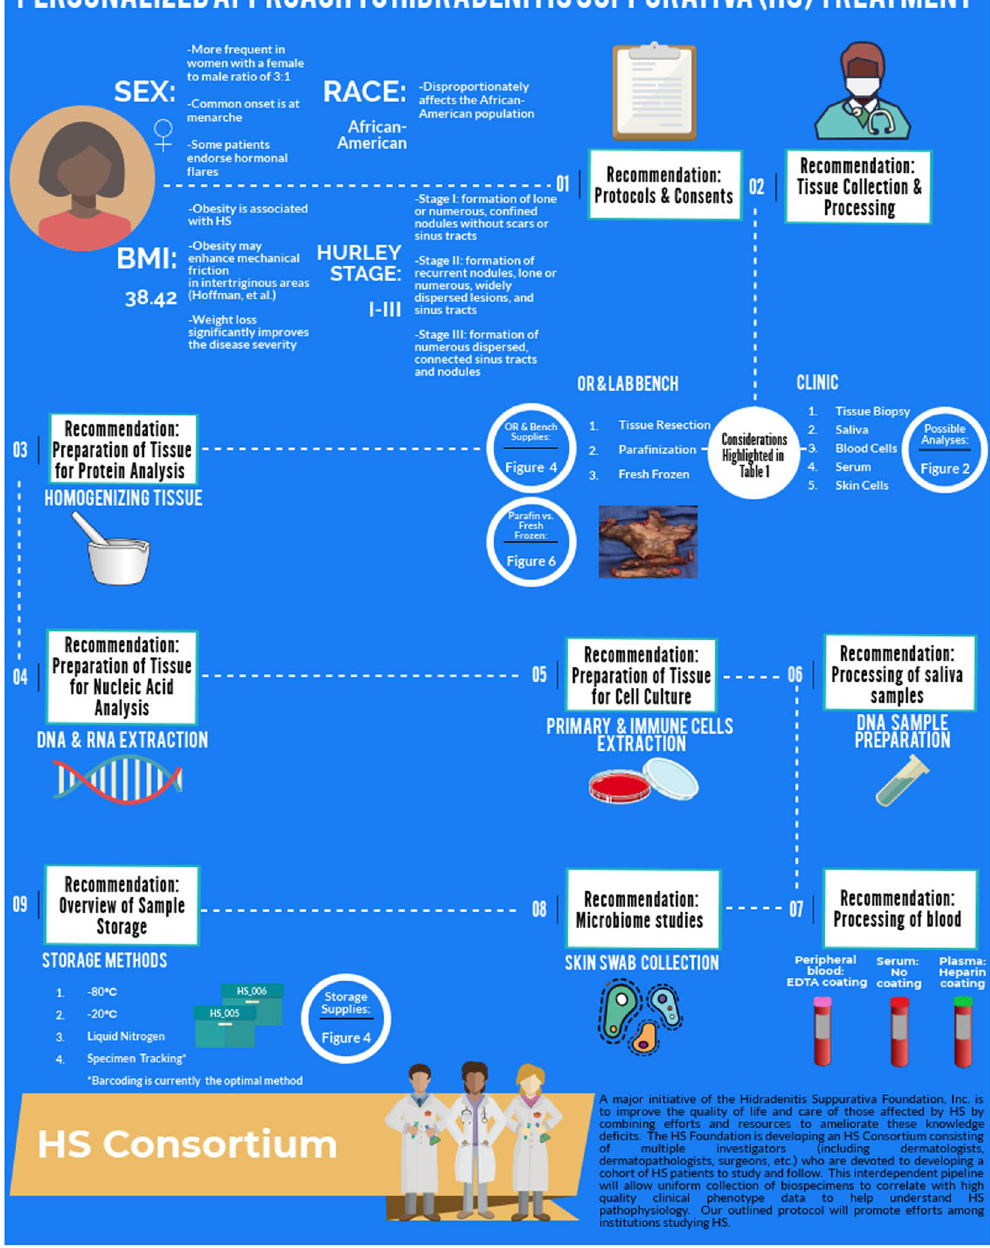
Figure 1. Overview of the personalized approach taken to biobank HS samples and the goals of the HS Consortium. Figure produced with